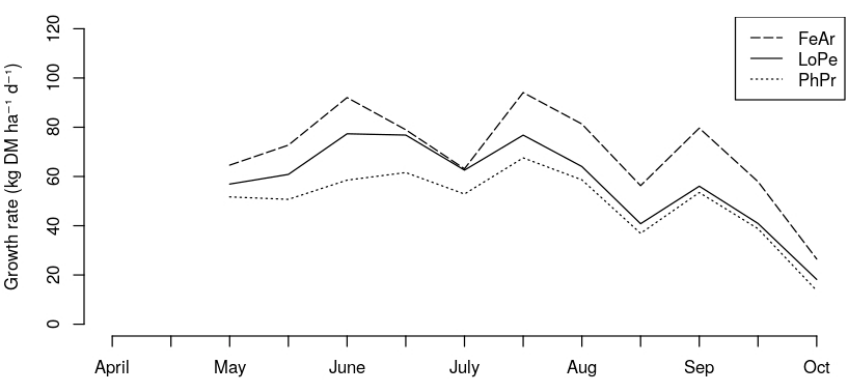
PhPr : Phleum pratense ; averaged over years and sites. Figure 1. Grazing regime: Growth rates (kg DM ha − 1 d − 1 ) of FeAr: Festuca arundinacea, LoPe: Lolium